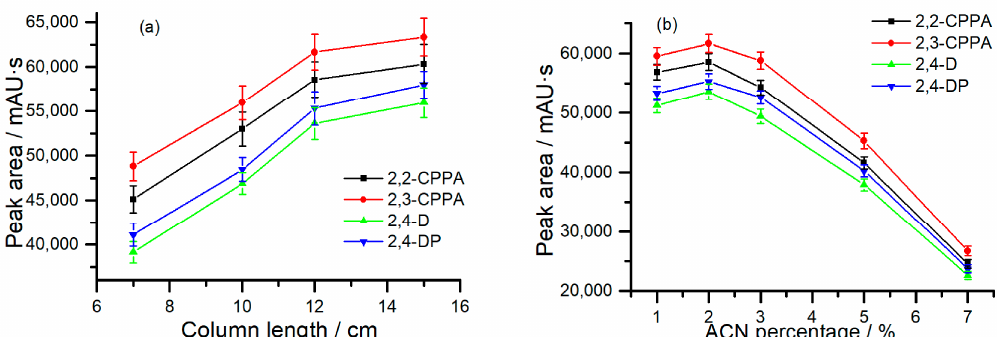
Figure 3. ( a ) Effect of the length of the monolithic column on the extraction efficiencies of the analytes; ( b ) effect of the ACN percentage in the sampling solution on the extraction efficiencies of the analytes. Abbreviation: 2-(2-chloro)-phenoxy propionic acid (2,2-CPPA), 2-(3-chloro)-phenoxy propionic acid (2,3-CPPA) and 2-(2,4-dichlorophenoxy)-propionic acid (2,4-DP).